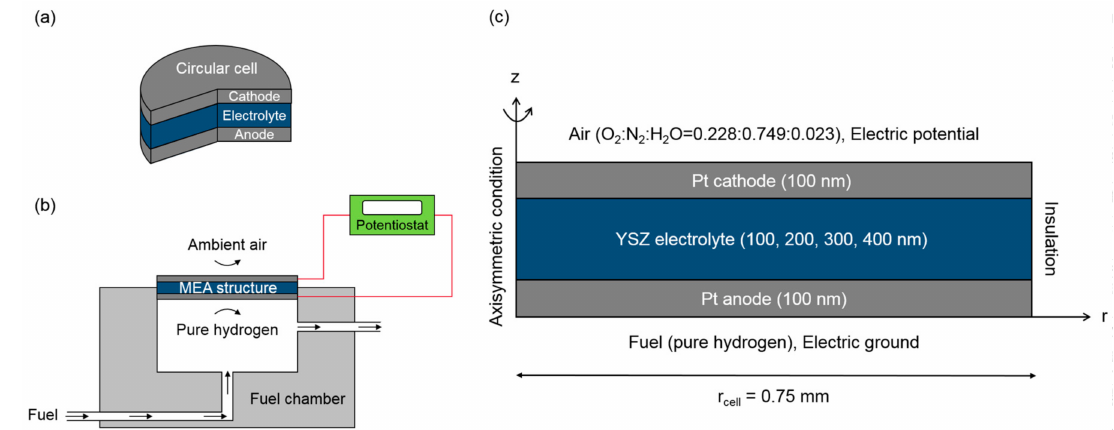
Figure 1. ( a ) Freestanding low temperature micro-solid oxide fuel cell ( µ -SOFC) single cell; ( b ) schematic of experimental setup for performance test with membrane electrode assembly (MEA) structure; and, ( c ) geometry and boundary conditions for numerical